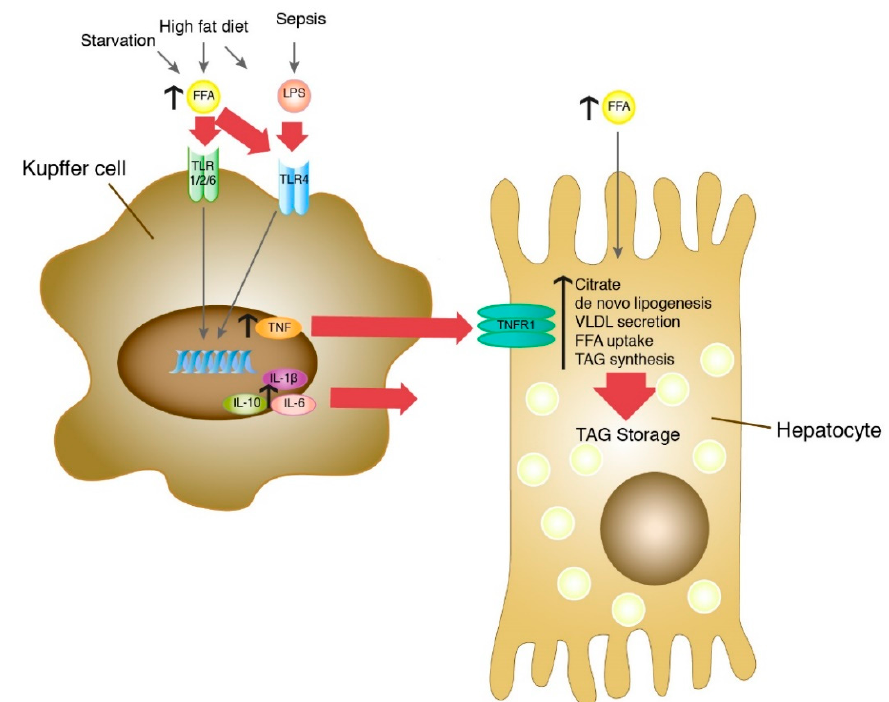
Figure 8. The role of Kup ff er cells as hepatic sensory cells in the development of steatosis in hepatocytes. Increased FFA can be caused by lipolysis in adipose tissue during starvation or by excess nutritional intake in high-fat diet. Elevated LPS levels can be caused by high-fat diet or sepsis. Both FFA and LPS bind to Toll-like receptors on the surface of Kup ff er cells and lead to increased secretion of IL-1 β , IL-10 und IL-6 and TNF. Secreted TNF binds to the TNFR1 receptor on hepatocytes and leads to increased citrate levels, de novo lipogenesis, FFA uptake and TAG synthesis and to a reduced VLDL secretion. As a result, this leads to an increased TAG storage and formation of steatosis in hepatocytes. In this model, the Kup ff er cell is the primary sensor for both FFA overload and LPS, integrates these signals and utilizes TNF to transmit the information to the hepatocyte, which reacts by alteration of lipid metabolism.